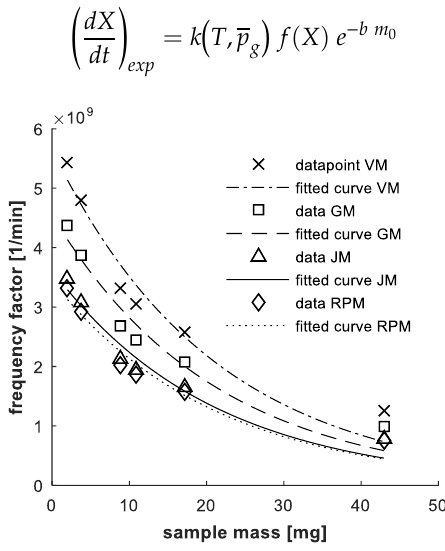
Figure 1. Frequency factor over sample mass for all four conversion models.